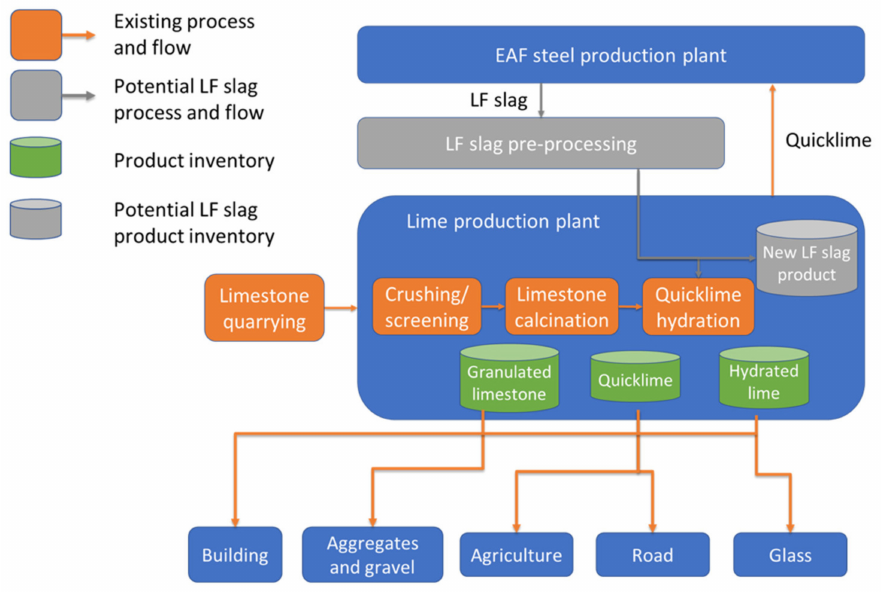
Figure 12. General framework for LF slag utilization